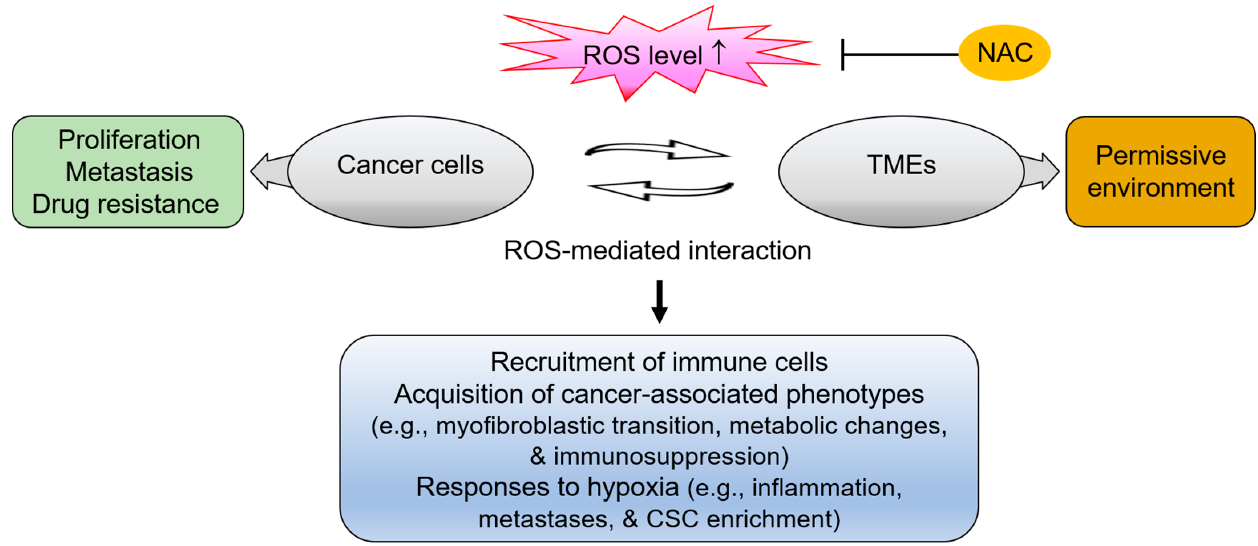
Figure 2. The involvement of reactive oxygen species (ROS) in the interplay between cancer cells and the tumor microenvironment (TME). The ROS-triggered signaling actively involves in interaction between cancer cell and the TME in TNBC. These ROS-mediated interactions induce the recruitment of immune cells, conversion of stromal cells into cancer-associated phenotypes (e.g., myofibroblastic transition, metabolic changes, and immunosuppression), and hypoxic responses (e.g., metastases, inflammation, and cancer stem-like cell (CSC) enrichment), thereby creating permissive TMEs and promoting malignant progression of cancer. N-acetylcysteine (NAC) treatment can effectively interfere with cancer cell-TME interactions by suppressing the ROS signaling that mediates the invasive, drug-resistant, metastatic properties of TNBC cells.